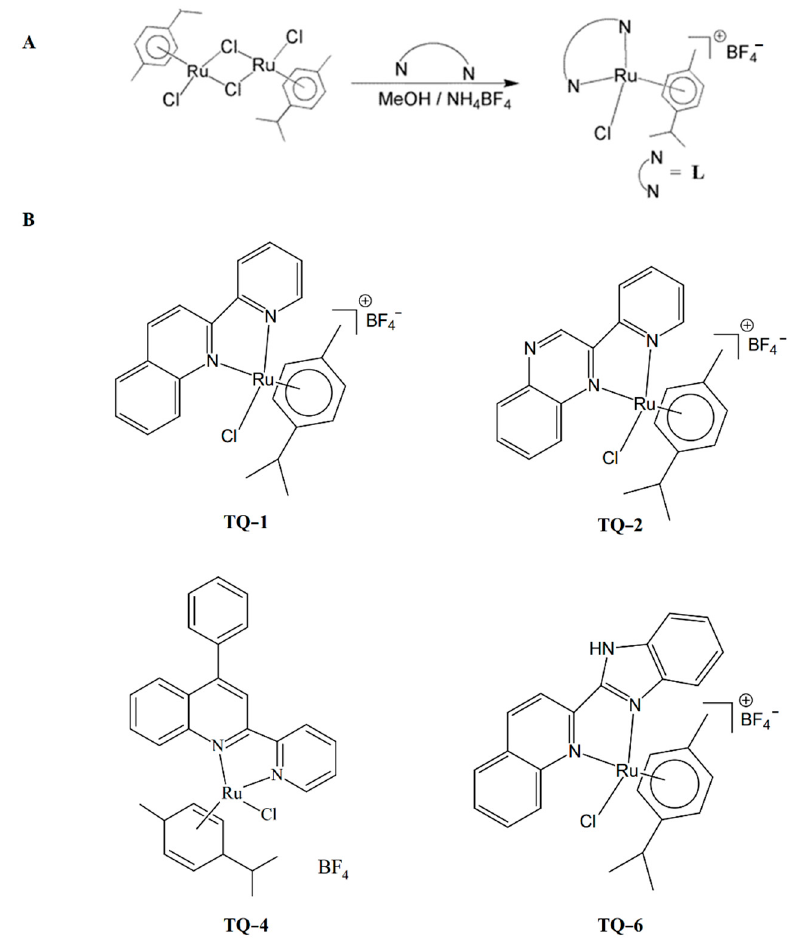
Figure 1. Scheme of synthesis of ligands ( A ) and complexes ( B ) of ruthenium compounds.